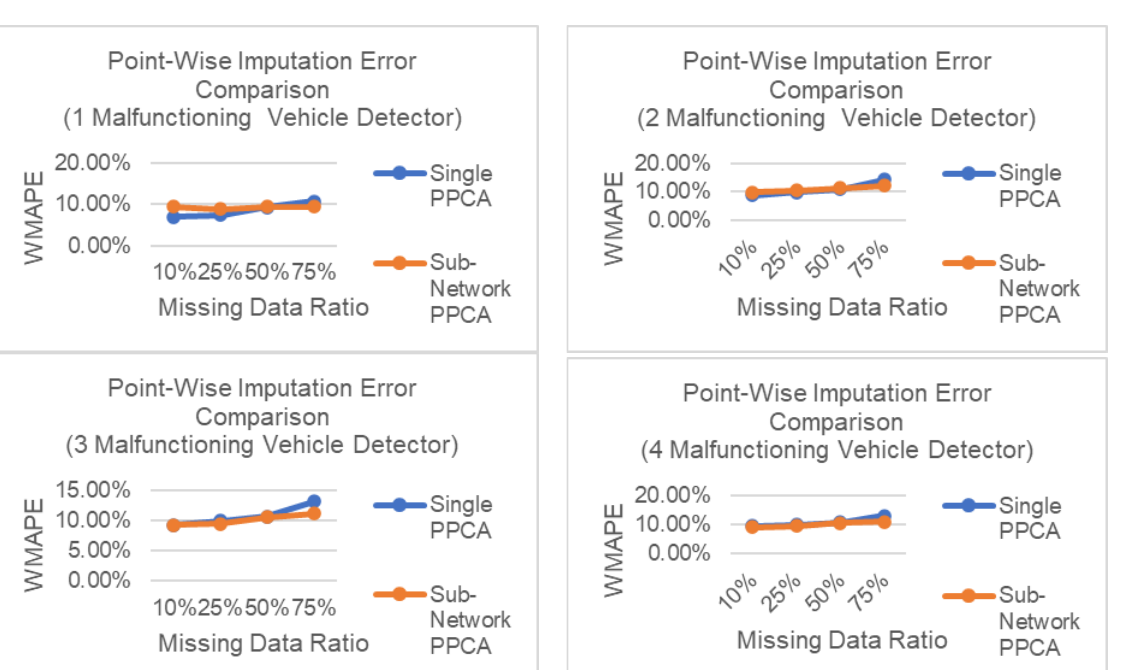
Figure 10. Failed data imputation points for in Scenario B for 75% point-wise missing data ratio.